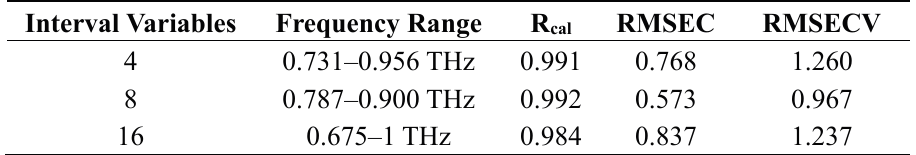
Table 3. Calibration and validation results obtained with the optimal iPLS regression model. Interval